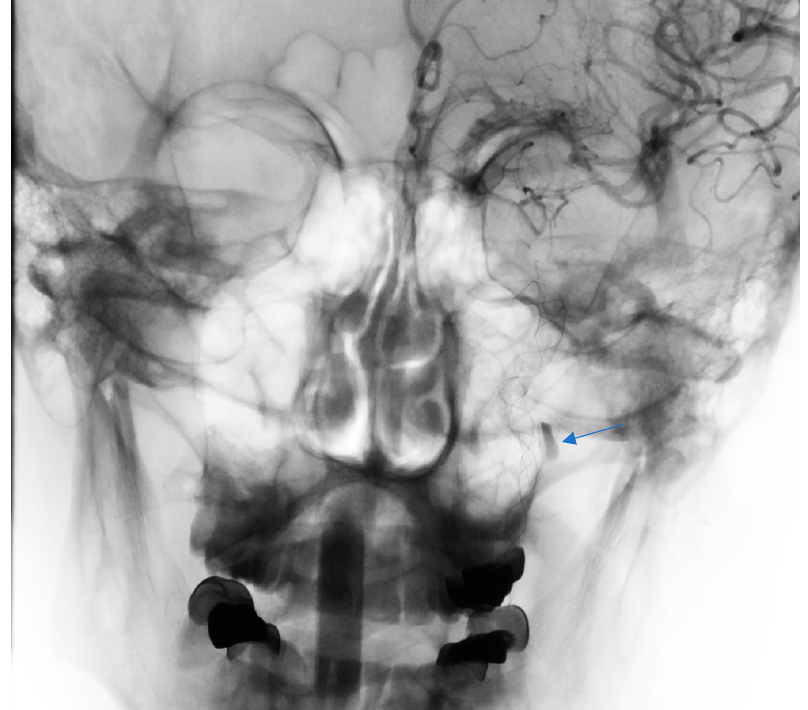
Figure 5. Stented left ICA with 2 overlapping stents covering the dissection and pseudoaneurysm with contrast medium stagnation (arrow) in late